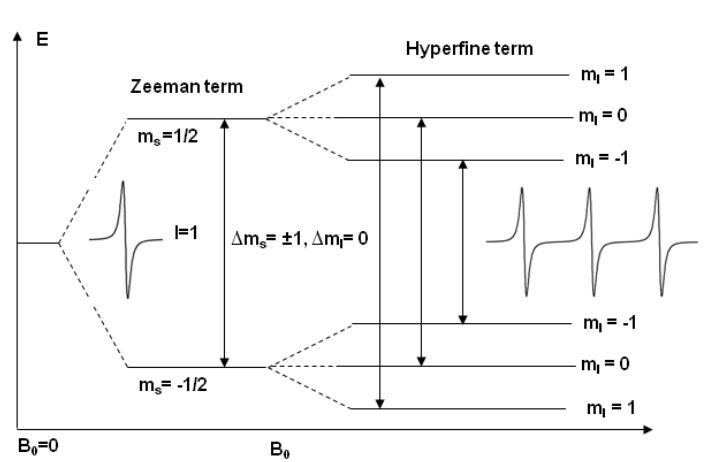
Figure 1. Energy level diagram of a nitroxide spin label in the presence of a static magnetic field (B 0 ). The inset traces show the corresponding electron paramagnetic resonance (EPR) spectrum in the absence and presence of a 14 N (I = 1) hyperfine interaction [19].